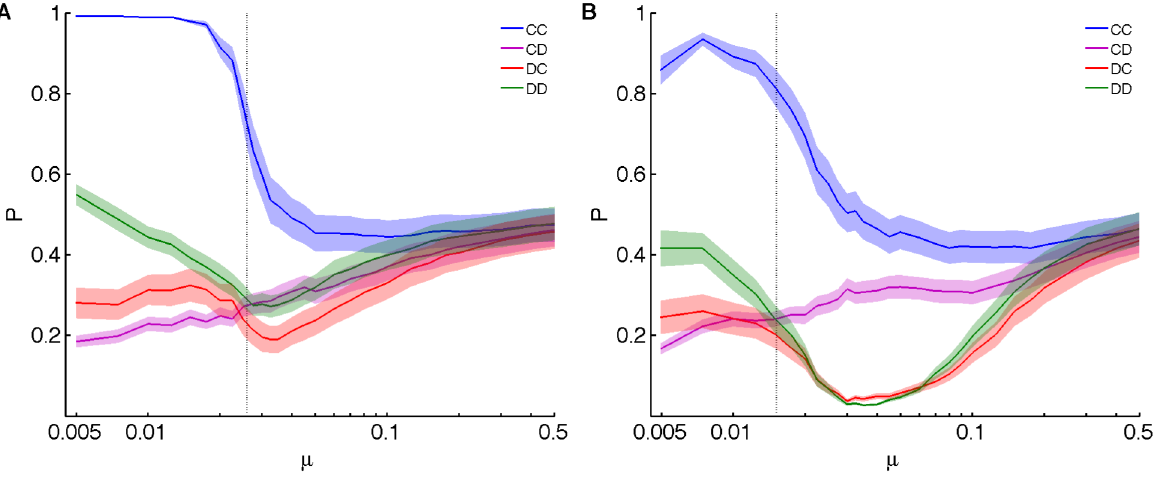
Figure 3. Evolution of consensus genotypes. Mean of probabilities of the consensus genotype as a function of mutation rate ( r =1%). Colored areas represent the variance of the probability distribution, and reflect the strength of selection. ( P C is omitted because it drifts neutrally, see Methods). Vertical lines drawn at the critical mutation rate. ( A ) Spatially-structured. ( B ) Well-mixed.